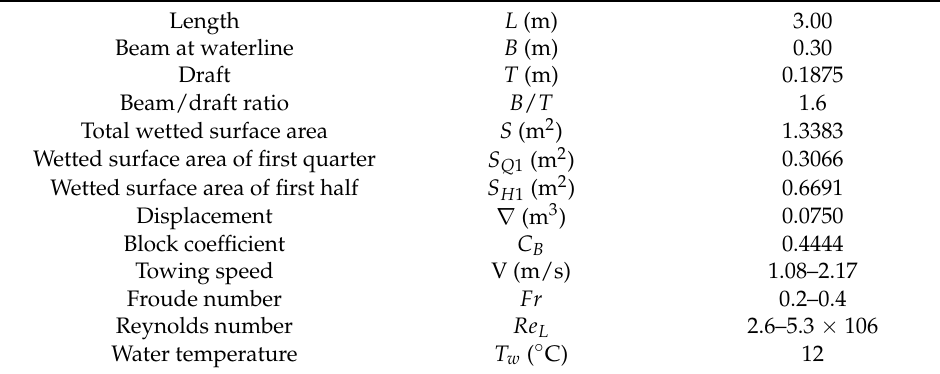
Table 1. Principal particulars of the Wigley model and simulation